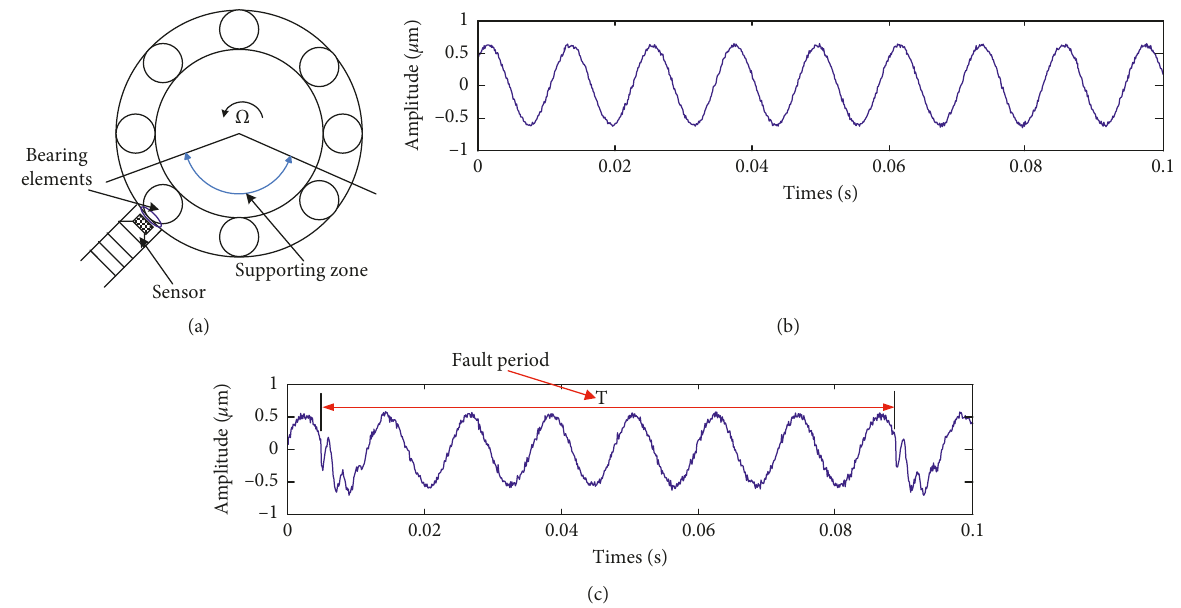
Figure 1: Principle and detection technology of the Hertz deformation: (a) measurement principle of the Hertz deformation; (b) high- quality signal of the eddy current sensor for bearing; (c) signals for bearings with defects on